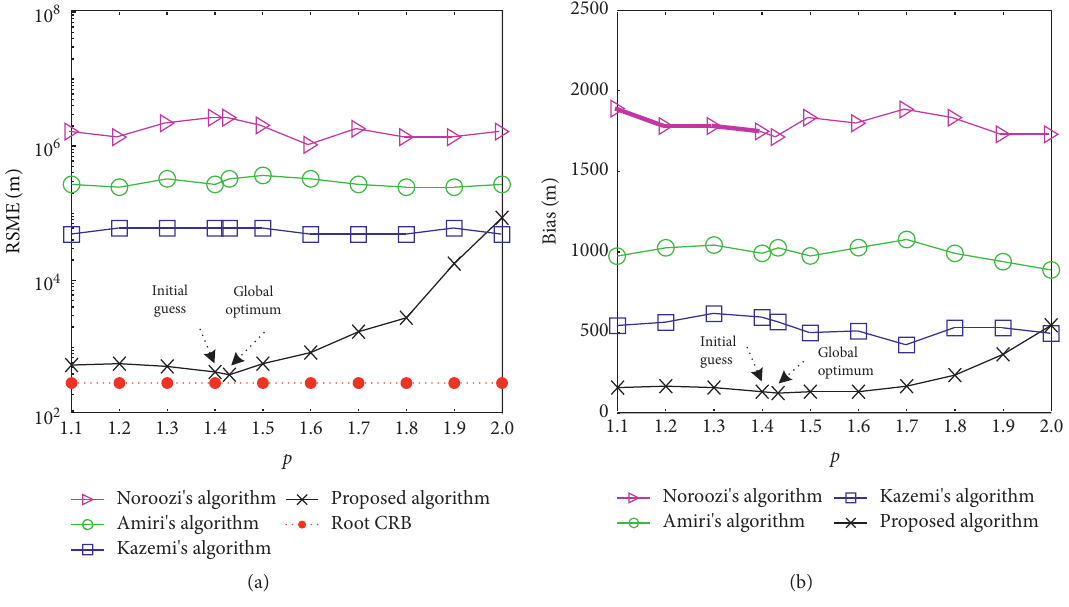
Figure 6: Localization (a) RMSE and (b) bias versus norm order p